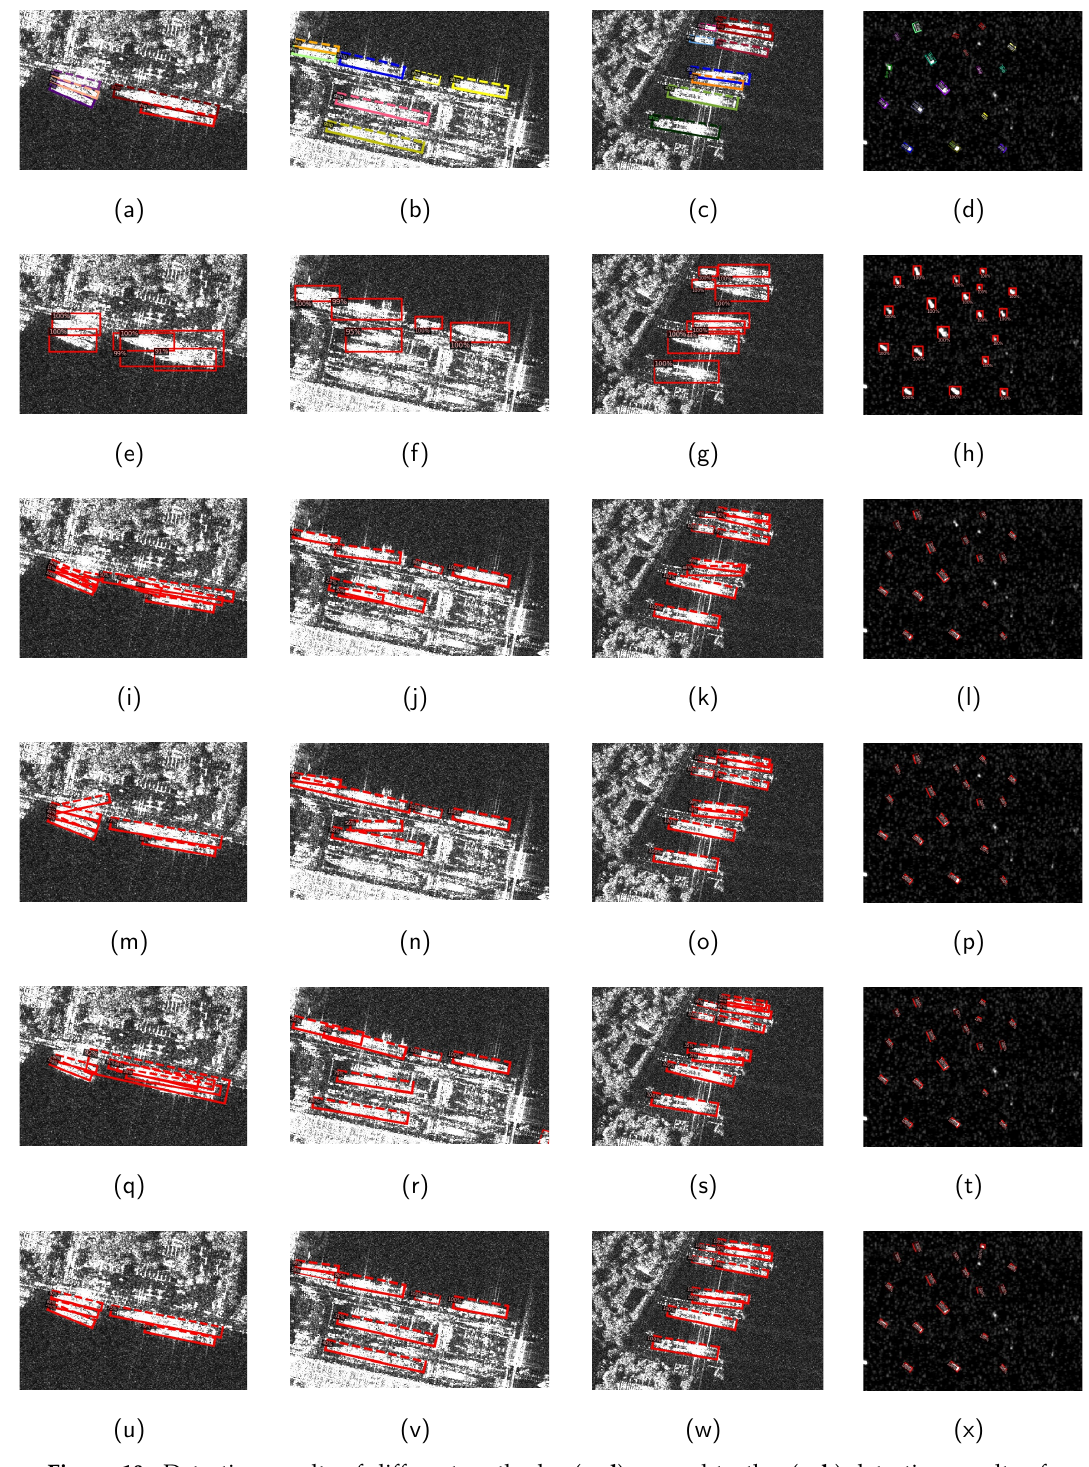
Figure 10. Detection results of different methods. ( a – d ) ground-truths; ( e – h ) detection results of MSHRN; ( i – l ) detection results of Faster RR-CNN; ( m – p ) detection results of R-FPN; ( q – t ) detection results of R-RetinaNet; ( u – x ) detection results of